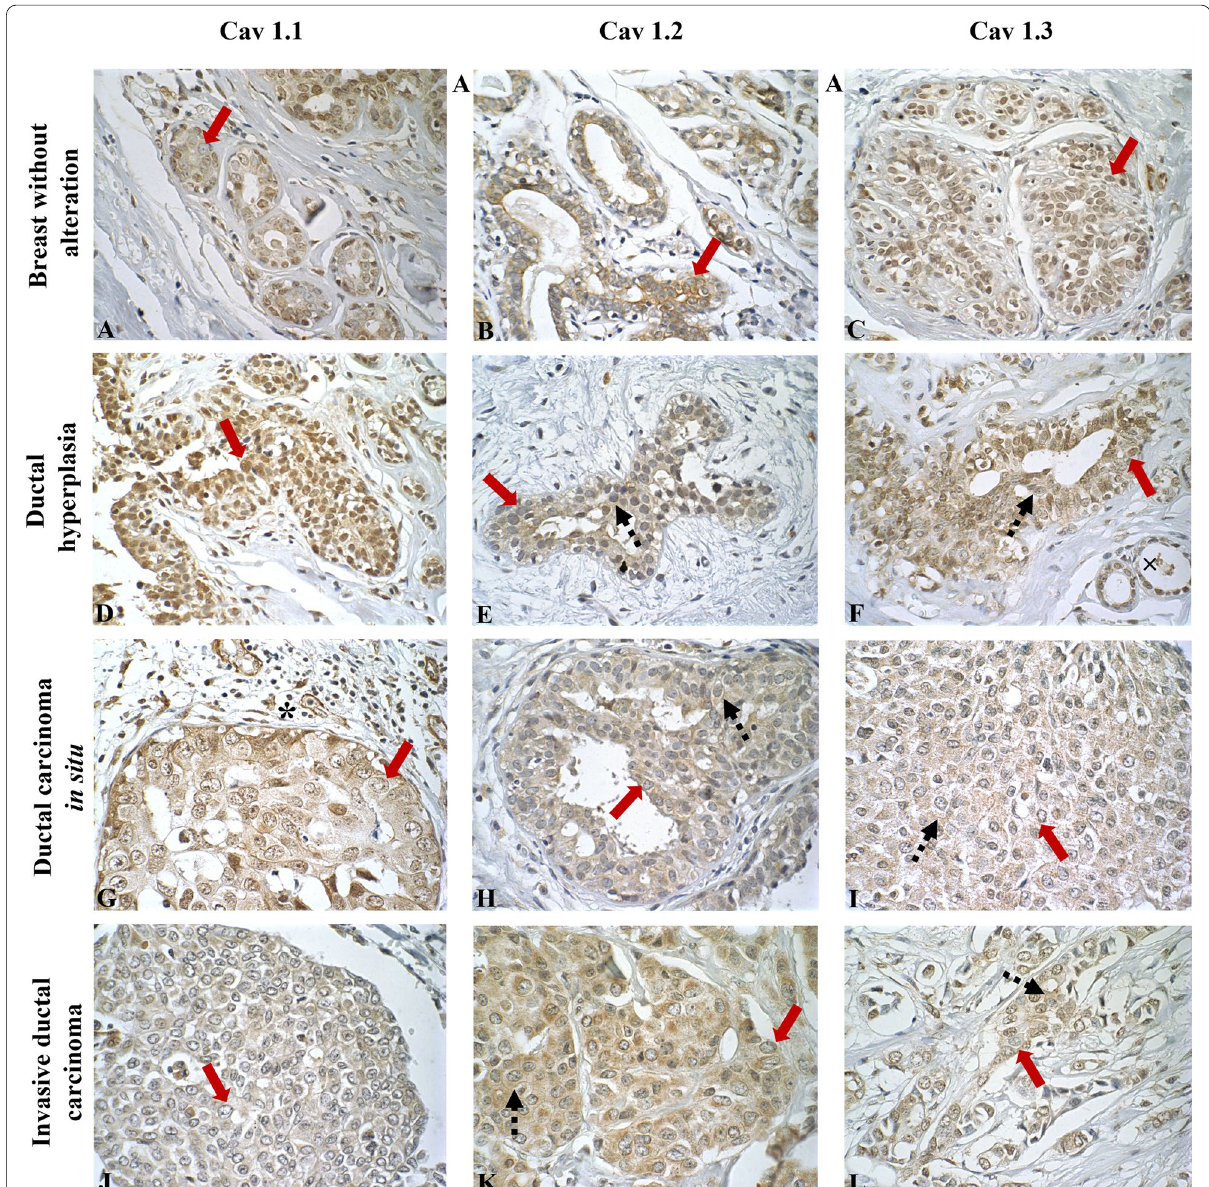
Fig 1. Human mammary glands with immunostaining for Ca V 1.1, Ca V 1.2 and Ca V 1.3. Identified by DAB chromogen and counterstained with hematoxylin. 600x magnification. A - C mammary lobes without histological alterations. D - F ductal regions with three or more layers of epithelial cells above the basal membrane and presence of a ductal region without alteration in F ( ). G - I epithelial cell proliferation forming intraductal × projections or solid masses restricted to the terminal ductal lobular units with an inflammatory infiltrate associated in G (*). J - L atypical epithelial proliferation, creating isolated cell nests in the mammary